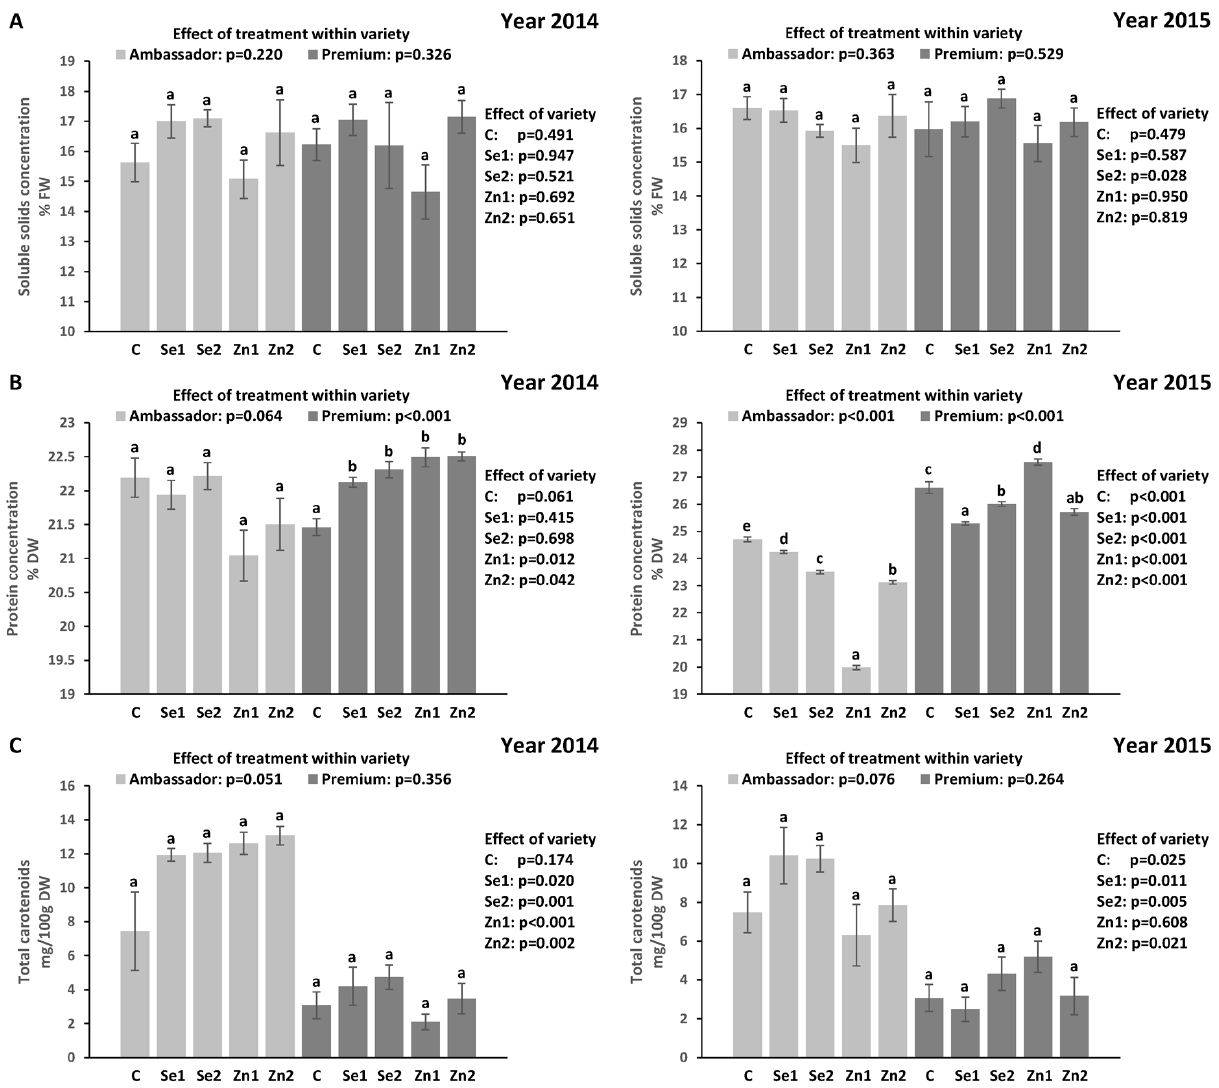
Figure 1. Effect of foliar Se and Zn treatments and variety in two growing seasons (2014 and 2015) on the concentration of soluble solids ( A ), protein ( B ) and total carotenoid ( C ) in pea seeds. C (control): without Se and Zn; Se1: 50 g Se/ha; Se2: 100 g Se/ha; Zn1: 375 g Zn/ha; Zn2: 750 g Zn/ha; mean ± SD; n = 4. Bars not sharing the same lowercase letters (superscripts) are significantly different within variety. p -values on the right side of the figure show the effect of treatment across the two varieties (i.e., Ambassador vs. Premium).